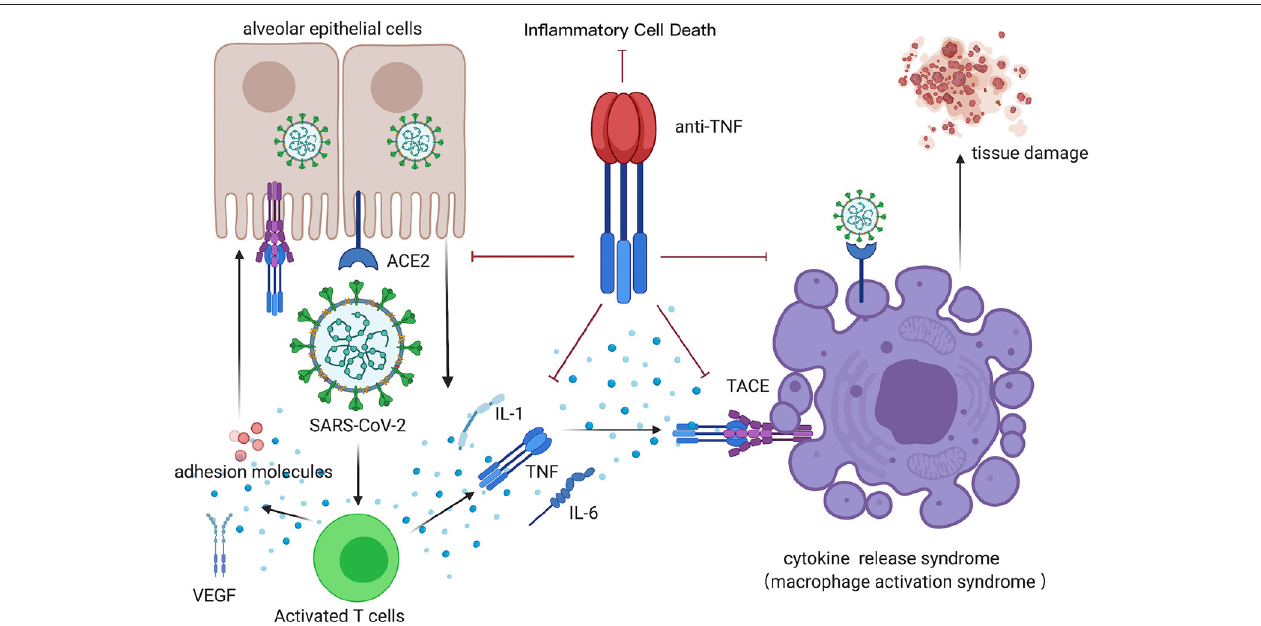
FIGURE 1 | CRS after COVID-19 infection, inhibited by anti-TNF therapy. TNF, tumor necrosis factor; ACE, angiotensin-converting enzyme; TACE, TNF- α -converting enzyme; VEGF, vascular endothelial growth factor; IL-1, interleukin-1; IL-6, interleukin-6. This figure was generated in Biorender (https://Biorender.com).